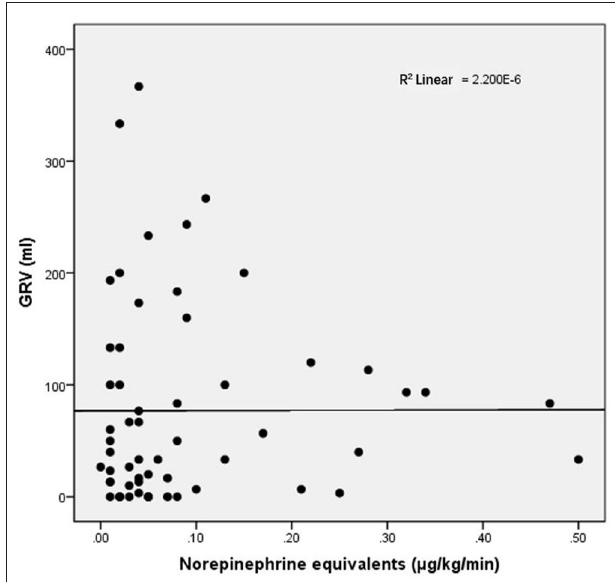
FIGURE 2 | Relationship between vasoactive drug dosage and GRV. GRV, gastric residual